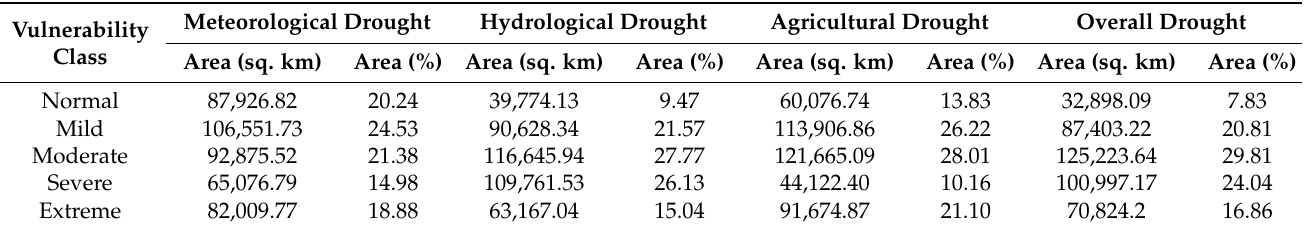
Table 4. Area coverage of meteorological, hydrological, agricultural and overall drought vulnerability classes and share of drought events according to the defined drought vulnerability